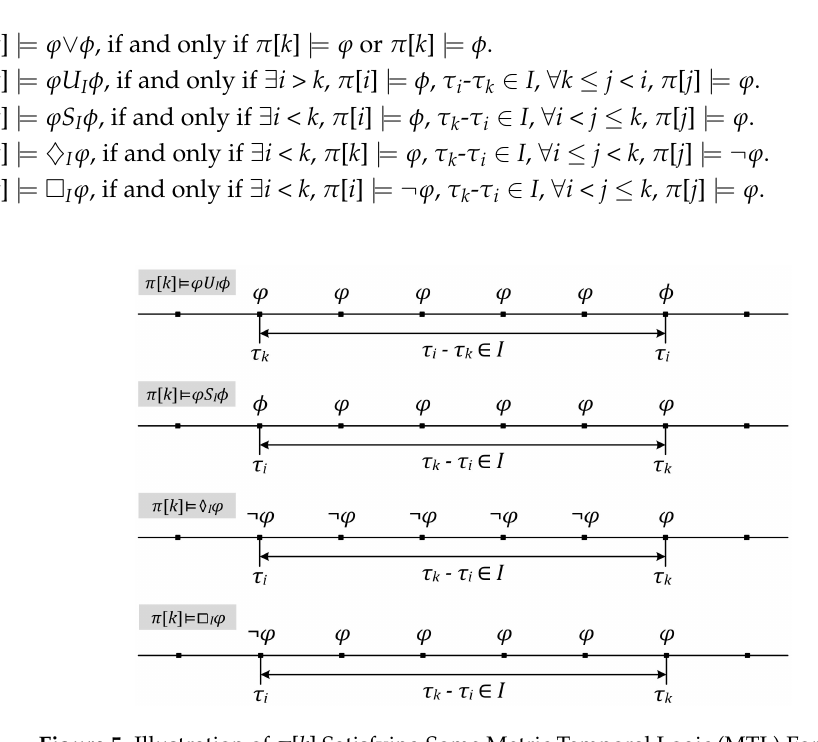
Figure 5. Illustration of π [ k ] Satisfying Some Metric Temporal Logic (MTL)